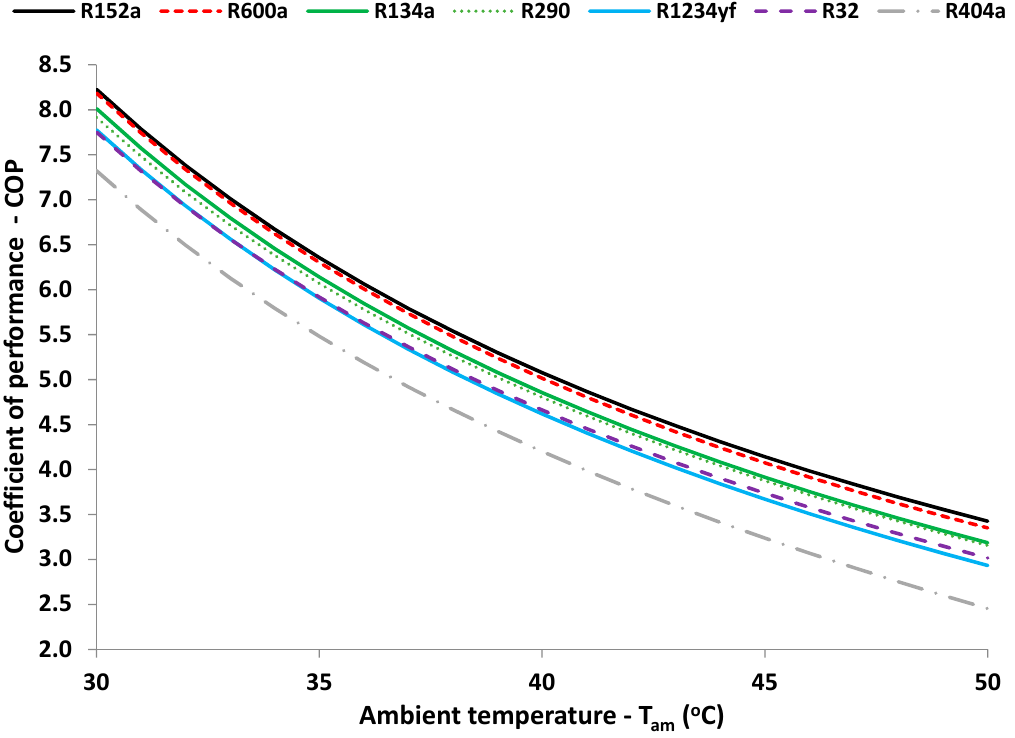
Figure 20. Comparison of different working fluids for Q e = 5 kW and T ind = 25 °C.